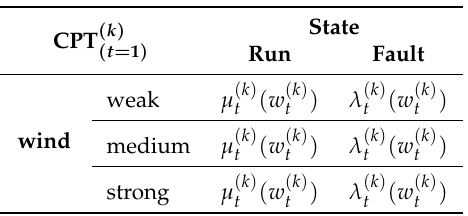
Table 2. CPT for t = 1.